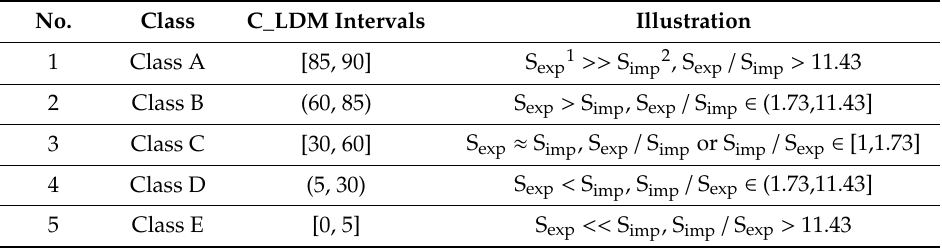
Table 1. Head / Tail Breaks intervals of C_LDM.